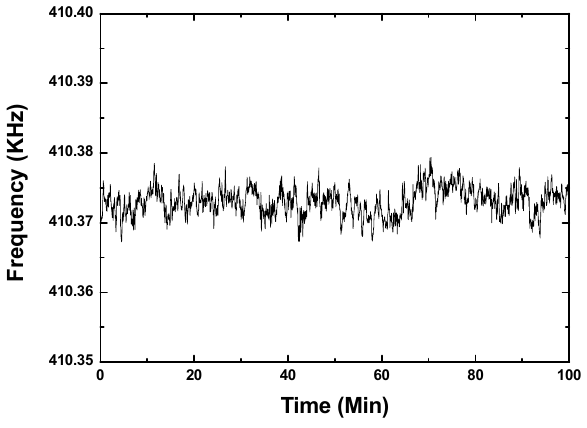
Figure 11. The baseline noise measurement of the developed sensor.